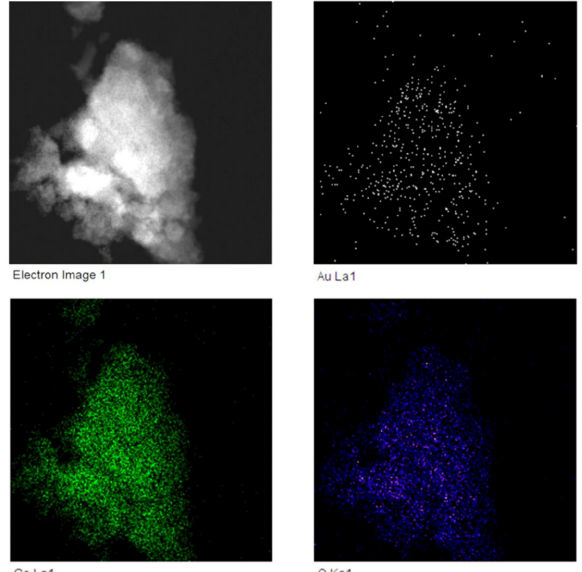
Figure 2. Dark field scanning electron microscopy of 0.82% AuCeO 2 catalyst and EDX elemental mapping of gold, cerium and oxygen demonstrating that these elements are evenly distributed in the particle. In addition, we evaluated HR-STEM images and corresponding histograms of na- noparticle size distribution (Figure 3).